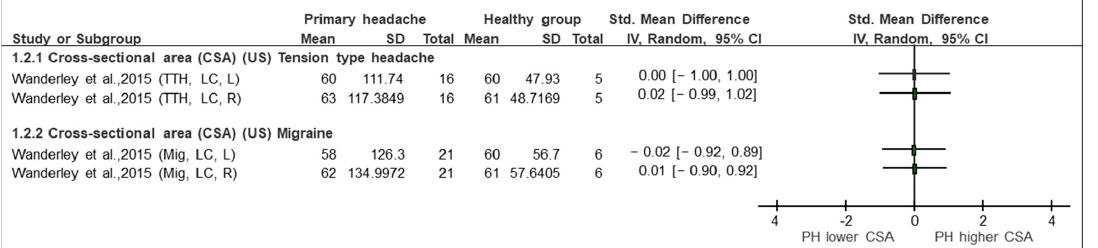
Figure 4. Forest plot of muscle volume quantification by magnetic resonance imaging (MRI). Graph shows the direction of change in muscle size in patients with primary headache towards a lower or higher MVQ. Mig: migraine, RCPmi: rectus capitis posterior minor, PH: primary headache, ♀ : fe- male, ♂ : male, lower volume: smaller area, higher volume: larger area. Authors: Hvedstrup et al. [23] . 3.6. Morphometric Alterations This section is divided according to the analysis presented by the studies and as re- flected in the forest plots (Figures 2–4). • TTH vs. control (CSA, MRI) (Figure 2): Two studies [35,37] investigated TTH and an- alysed the CSA of the RCPmi, RCPma, rotators, multifidus, and semispinalis cervicis compared with an asymptomatic control group. As shown in the forest plot (Figure 2), the study by Oksanen et al. [37] did not observe statistically significant differences in any of the variables when comparing TTH and the control subjects. This study assessed the CSA in rotator, multifidus, and semispinalis cervicis, both in females in the right side. The SMD ranged from 0.16 to − 0.41. In contrast, Fernández de las Peñas et al. [35] observed statistically significant differences between groups. The magni- tude of effects (SMD) in the different comparisons was greater. The SMDs ranged from − 0.89 to − 1.46. These differences were considered clinically relevant [35]. • Migraine vs. control (CSA, MRI) (Figure 2): Only one [37] of the five included studies evaluated the CSA of the rotator, multifidus and semispinalis cervicis, comparing subjects with migraine and asymptomatic subjects. The results, displayed in the for- est plot (Figure 2), show changes in the different groups of interest. The area of the three named muscles was assessed with a unique measure separated by sexes. The values were grouped for males and females. The SMDs ranged from 0.69 to − 0.45. Changes were noted, but they were not of a sufficient magnitude to be considered relevant. The CSA in the extensor muscles was greater ( p < 00.1) in men than in women [37]. • Primary headache (general) vs. control (CSA, MRI ) (Figure 2): Only the study by Yuan et al. [25] evaluated the CSA as a variable in a primary (general) headache group in the RCPmi of the head compared with an asymptomatic group. Looking at